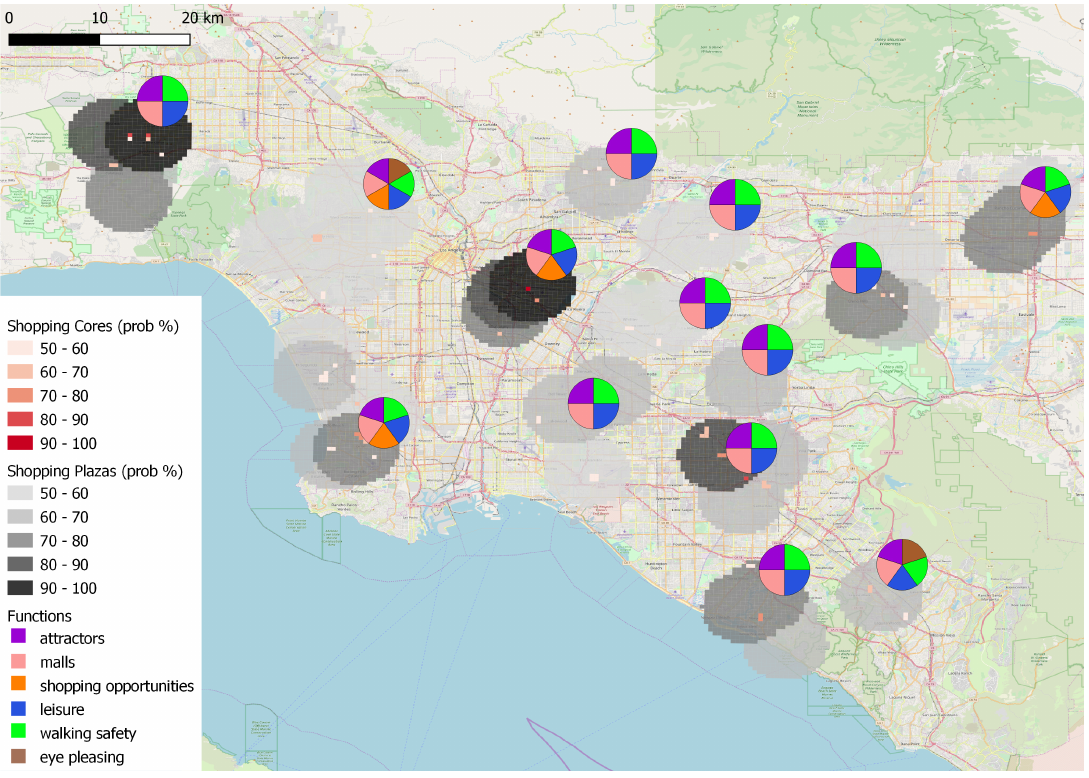
Figure 7. Final results combining data-to-knowledge and knowledge-to-data